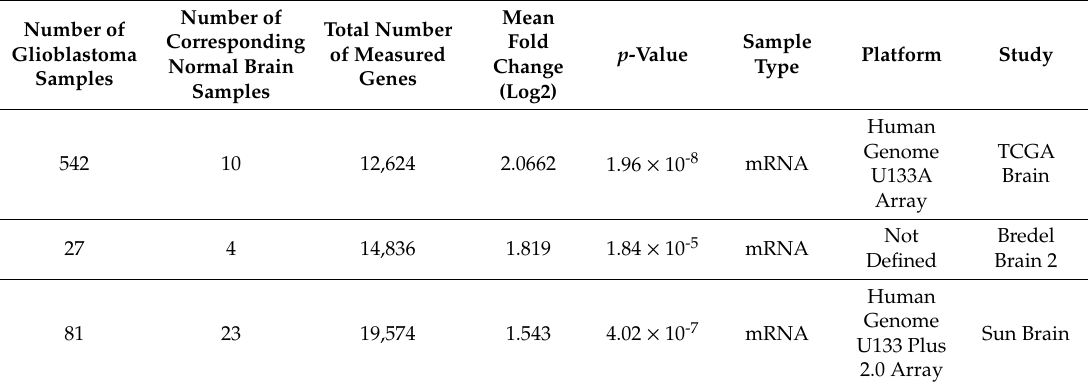
Table 1. Cathepsin B over-expression in glioblastoma compared to normal brain. Number of